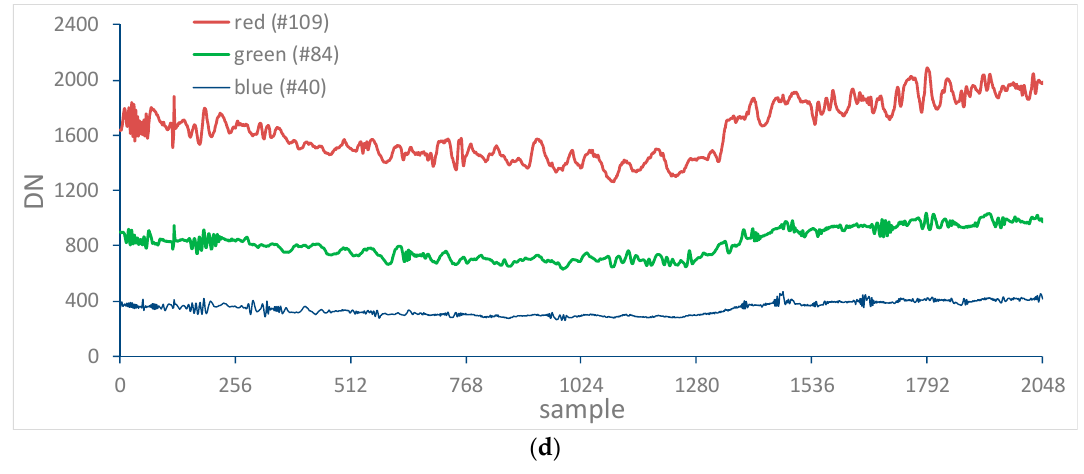
Figure 20. Row-averaged values at 650.4 nm, 551.5 nm, and 461.7 nm from images acquired over the calibration site on 7 March and 28 February 2017 using SPARK-01 ( a ) before and ( b ) after relative calibration, and at 638.0 nm, 549.5 nm, and 459.0 nm using SPARK-02 ( c ) before and ( d ) after relative calibration.